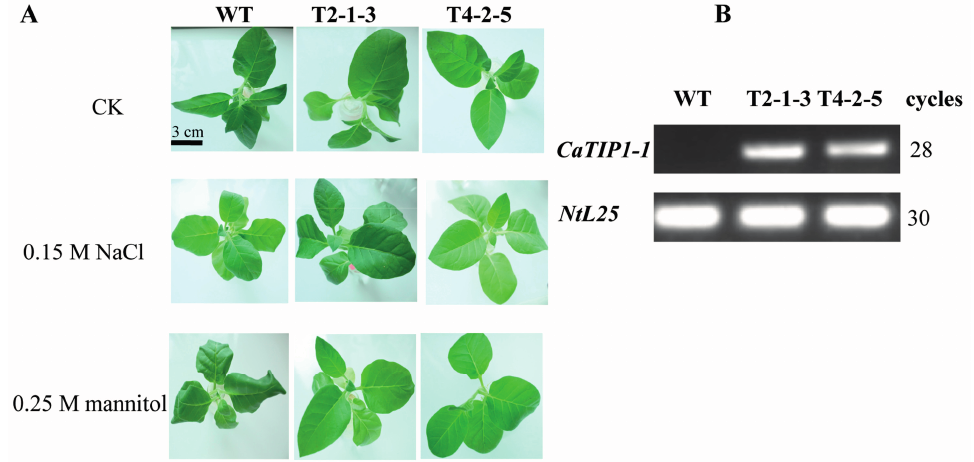
Figure 3. Phenotype analysis and expressions of CaTIP1-1 in WT and transgenic plants.